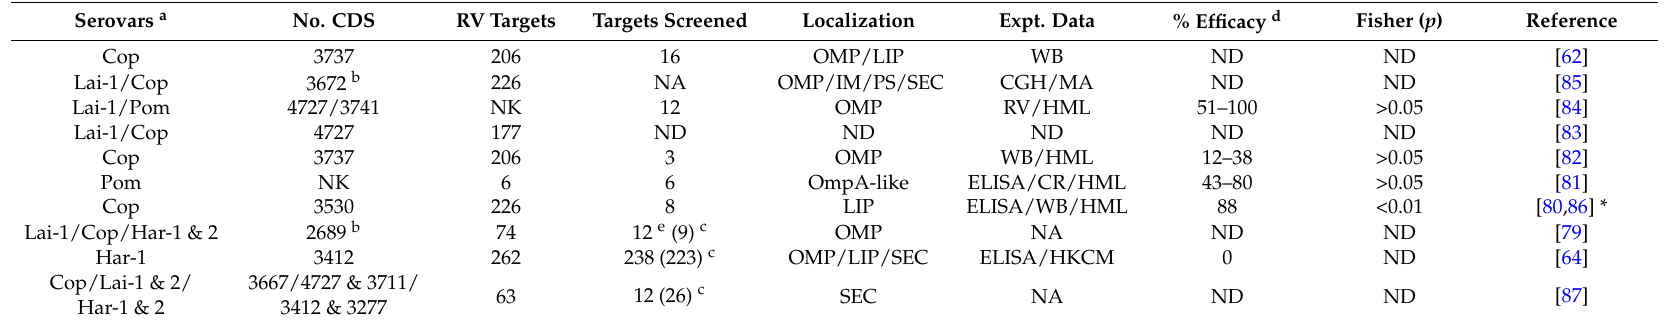
Table 1. Reverse vaccinology projects applied to Leptospira